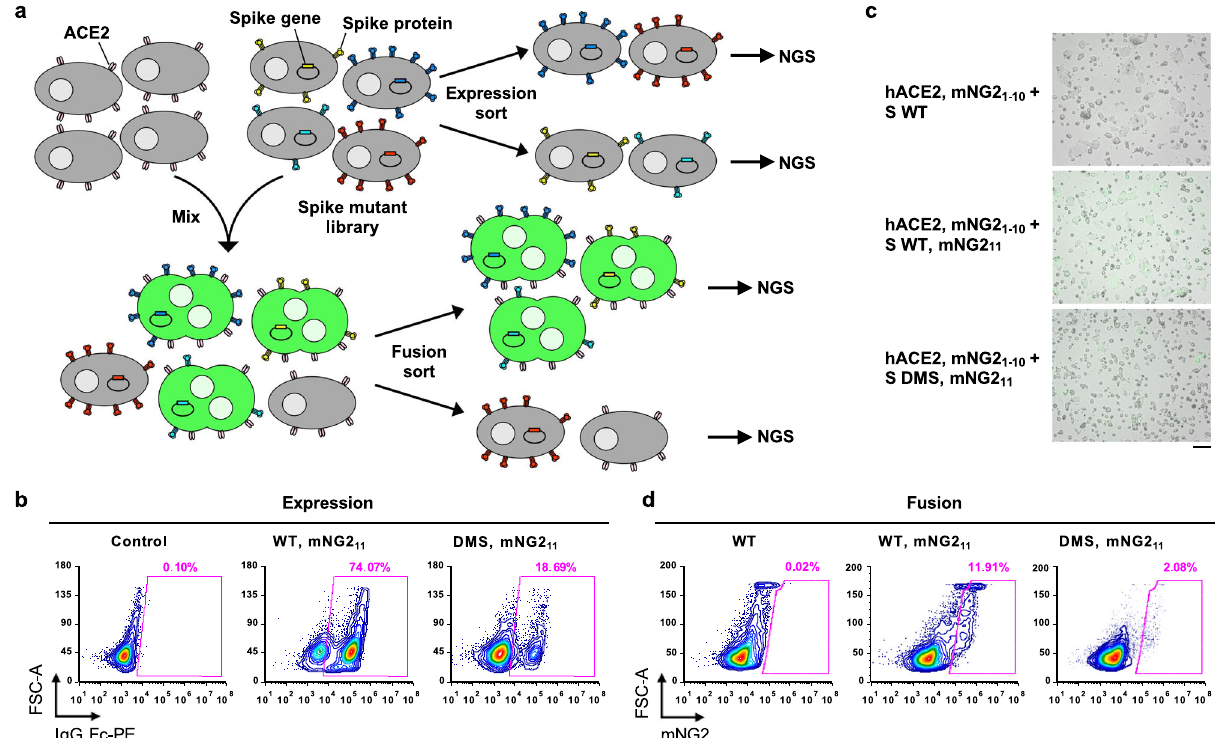
Fig. 1 | Measuring protein expression and fusogenicity of SARS-CoV-2 S mutations using deep mutational scanning. a Schematic of high-throughput expressionandfusionassaysforSmutants.ACE2-expressingandspike-expressing cells also express mNG2 1-10 and mNG2 11 , respectively. Four-way and two-way sorting were performed for expression and fusion sort, respectively. Fig. S11c, d show gating strategies for sorting. Next-generation sequencing (NGS) was per- formedonanampliconthatspannedaminoacids883 – 1034ofS. b Flowcytometry